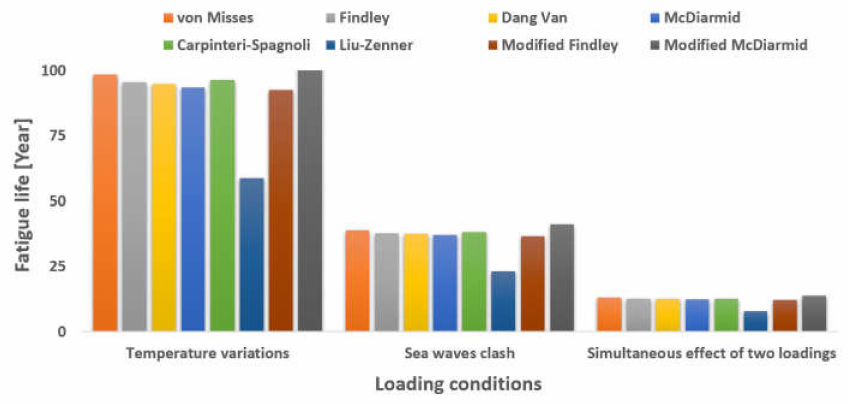
Figure 14. The fatigue lives predicted by various fatigue criteria in the top part of the steel piles as the critical zone (element No.